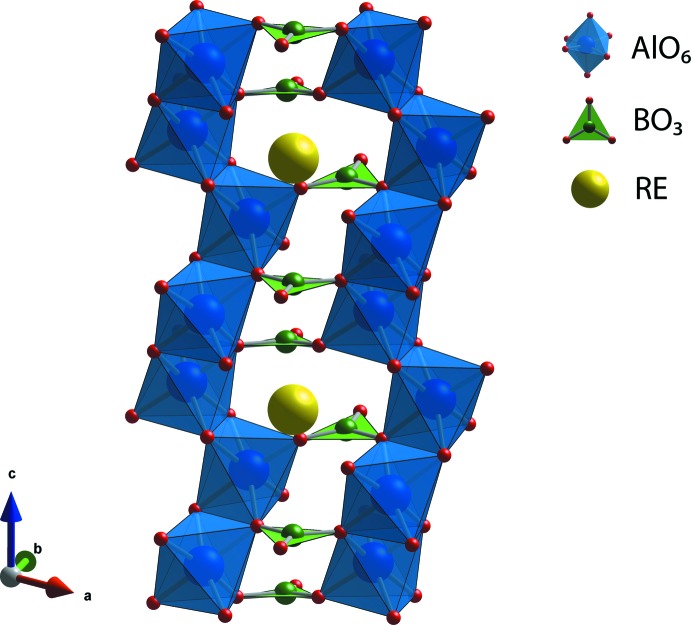
Structure showing the helical chains composed of edge sharing AlO6 units along the c axis connected by BO3 in REAl3(BO3)4.